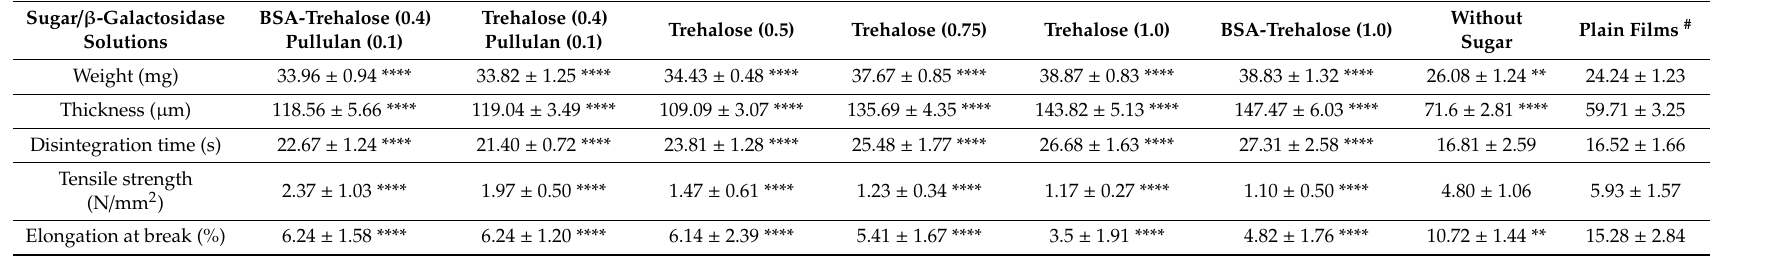
Table 3. Mass, thickness, disintegration time, and mechanical properties of air-dried ODFs with β -galactosidase. Sugar / β -Galactosidase